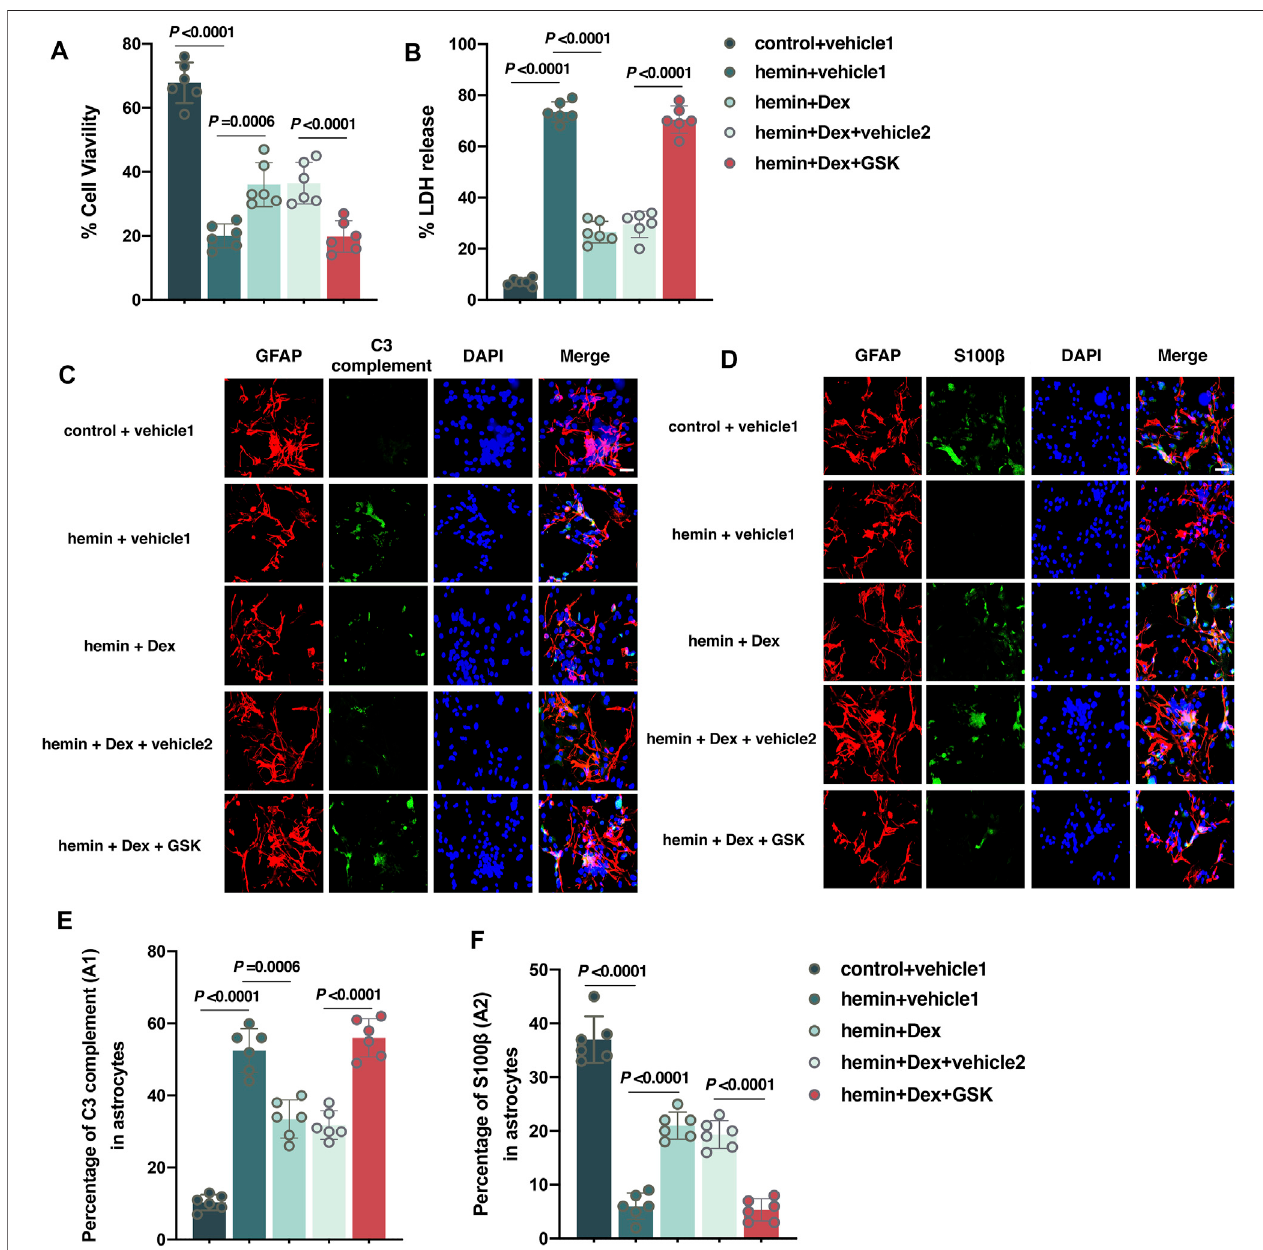
FIGURE 6 | Activation of the TPRV4 signal in astrocytes eliminates dexmedetomidine-mediated neuroprotective effects in vitro . (A,B) Changes in the cell viability and LDH releases in cultured astrocytescaused by theindicatedstimuli. (C) Representative photomicrographsofGFAPand C3 complementplus DAPI staining (GFAP, red; C3 complement, green; DAPI, blue). 400× magni fi cation, scale bar = 20 μ m. (D) Representative photomicrographs of GFAP and S100 β plus DAPI staining (GFAP, red;S100 β ,green;DAPI,blue).200×magni fi cation,scalebar=20 μ m. (E) ThepercentageofGFAPcombinedwithC3complement-positivecells(A1-type)caused bytheindicatedstimuli. (F) ThepercentageofGFAPcombinedwithS100 β -positivecells(A2-type)causedbytheindicatedstimuli.Dataarepresentedasthemean±SD ( n = 12 or 6). Hemin: 30 μ M of hemin for 12 h was used to imitate ICH in vitro ; Dex: Dex (1 μ M) was administered into cell culture 30 min after hemin treatment;